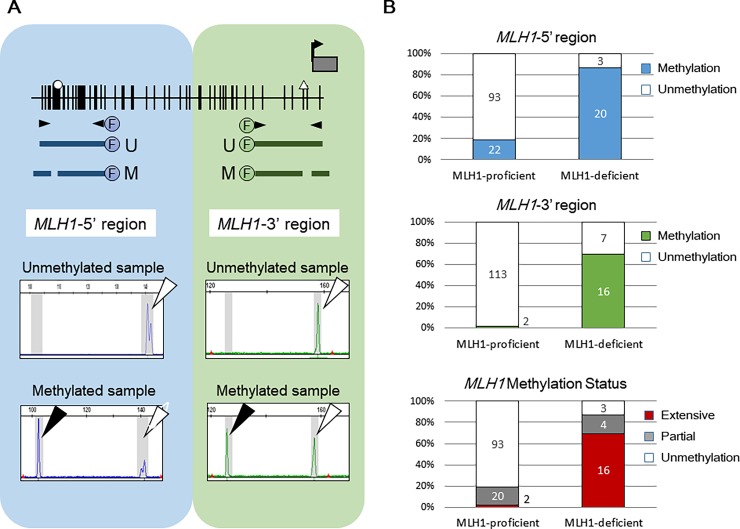
Methylation analysis of the promoter region in the MLH1 gene.(A) Schematic depiction of two regions (5’-region and 3’-region) of the MLH1 promoter for methylation and results of a panel of representative fluorescent bisulfite PCR following restriction enzyme analysis. Methylated samples had the new fragment cleaved by the restriction enzyme. (B) The frequencies of MLH1 promoter methylation according to MLH1 expression status. The top panel shows the results of the MLH1-5’ region, the middle panel shows the MLH1-3’ region and the bottom panel shows partial (i.e. only MLH1-5’ methylation) and extensive methylation (i.e. both MLH1-5’ and -3’ methylation).